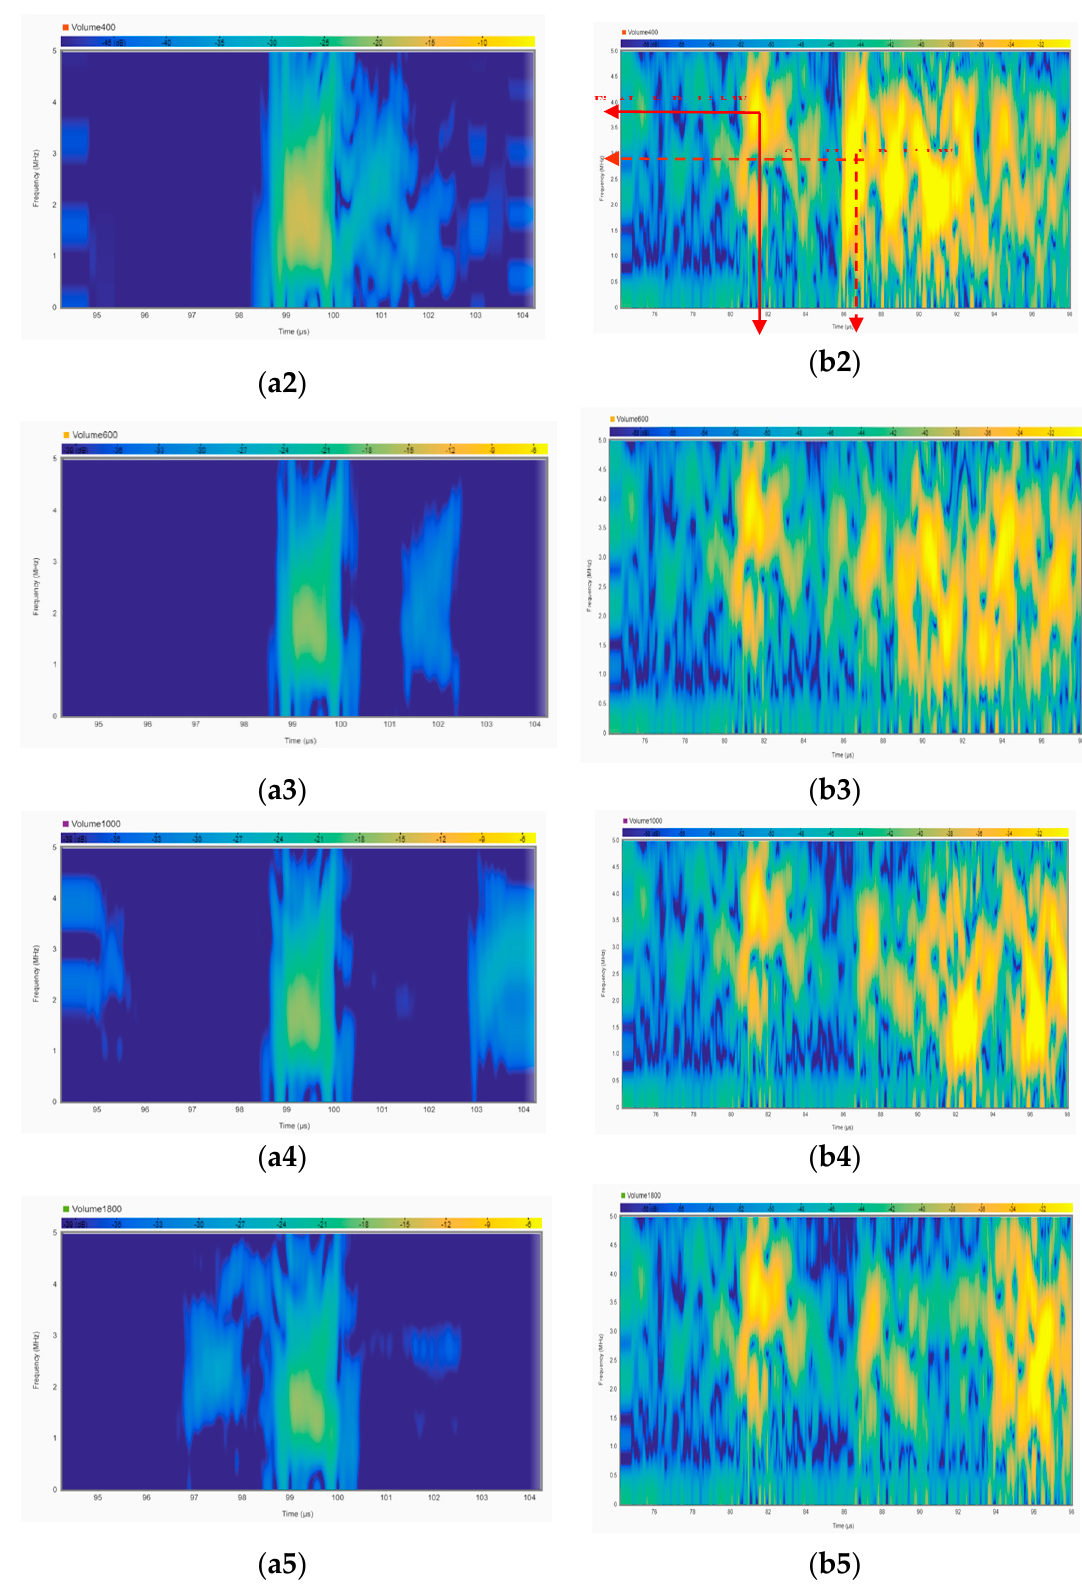
Figure 8. ( a ) Short-Time Fourier Transform for the reflection from edge / corner in all cases: ( a1 ) empty, ( a2 ) 400 μ L, ( a3 ) 600 μ L, ( a4 ) 1000 μ L, and ( a5 ) 1800 μ L; ( b ) STFT for the reflection from the liquid in all cases: ( b1 ) empty, ( b2 ) 400 μ L, ( b3 ) 600 μ L, ( b4 ) 1000 μ L, and ( b5 ) 1800 μ L.